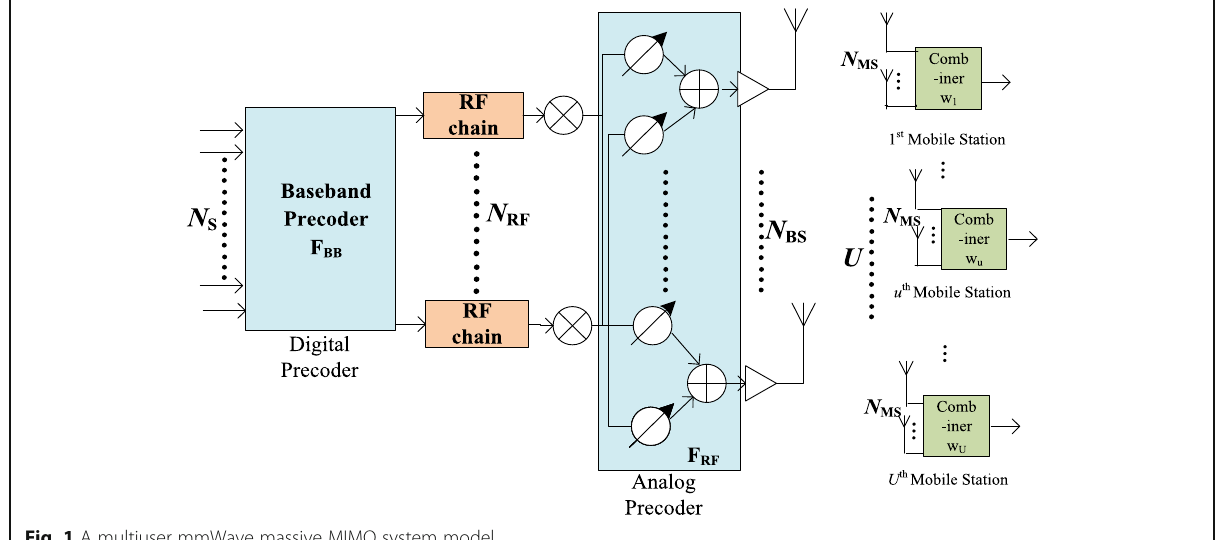
Fig. 1 A multiuser mmWave massive MIMO system